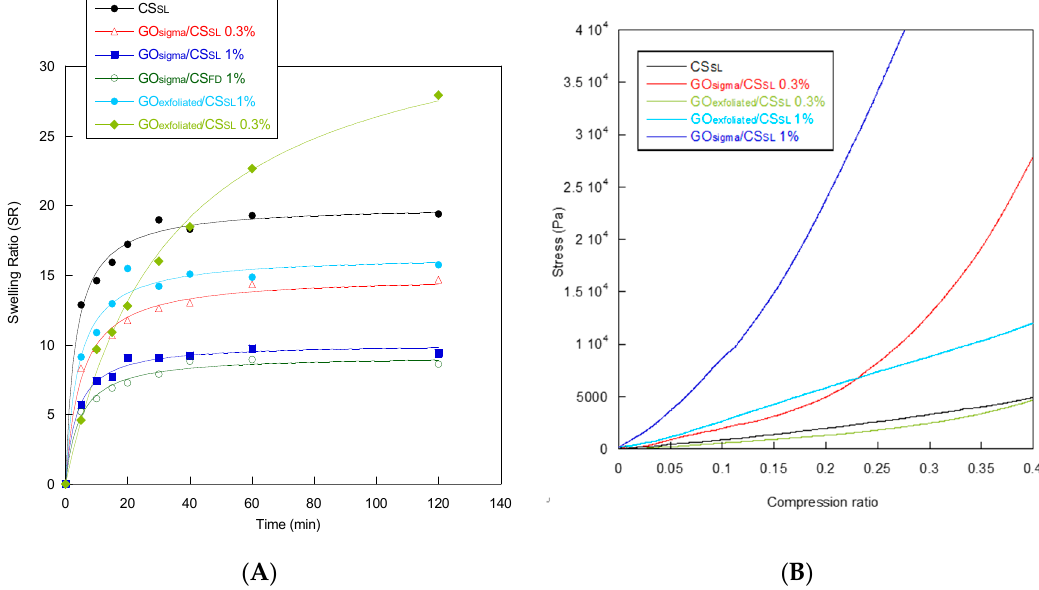
Figure 8. Swelling ratio ( A ) and mechanical behavior in compression tests ( B ) of the scaffolds. Table 5. Equilibrium swelling ratio (SW), water retention (WR), degradation temperature (T d ) and glass transition temperature (T g ) of chitosan and GO/CS composite